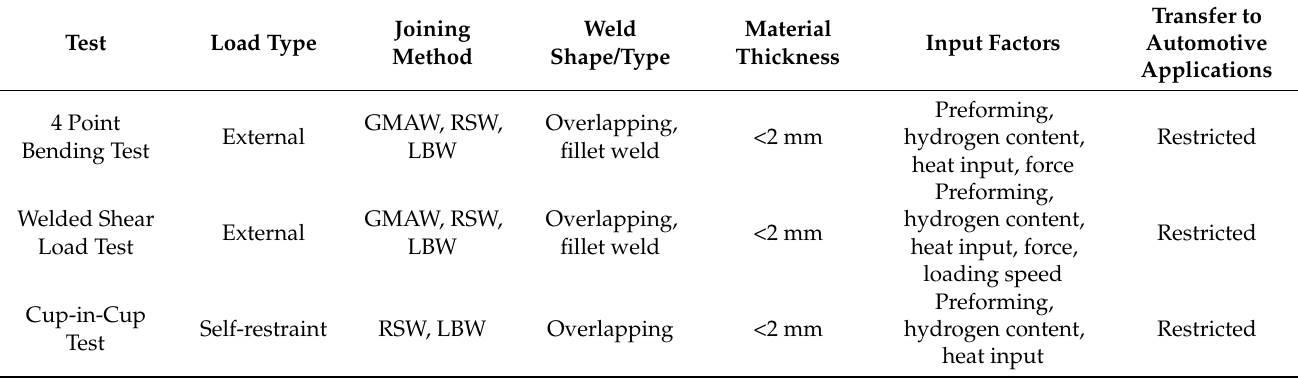
Table 2. Overview of recent studies on cold cracking